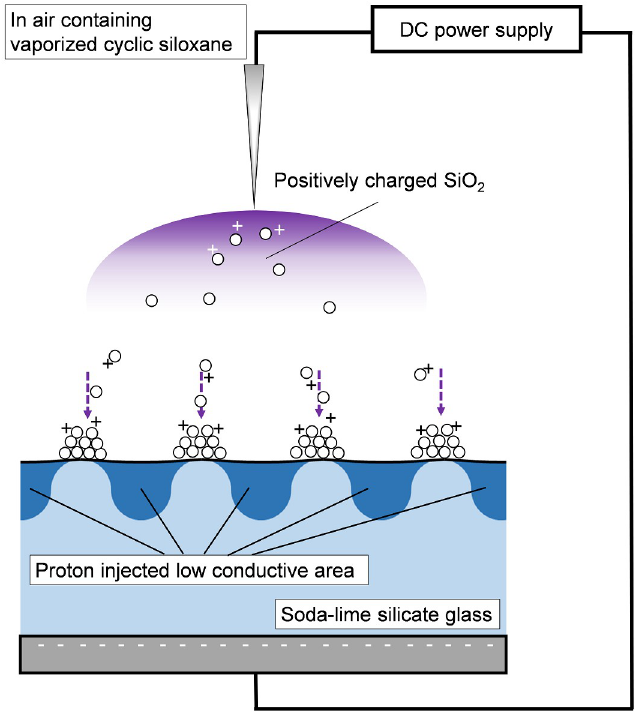
Fig 6. Schematic image of the formation of a surface relief hologram consisting of SiO 2 during CDD.